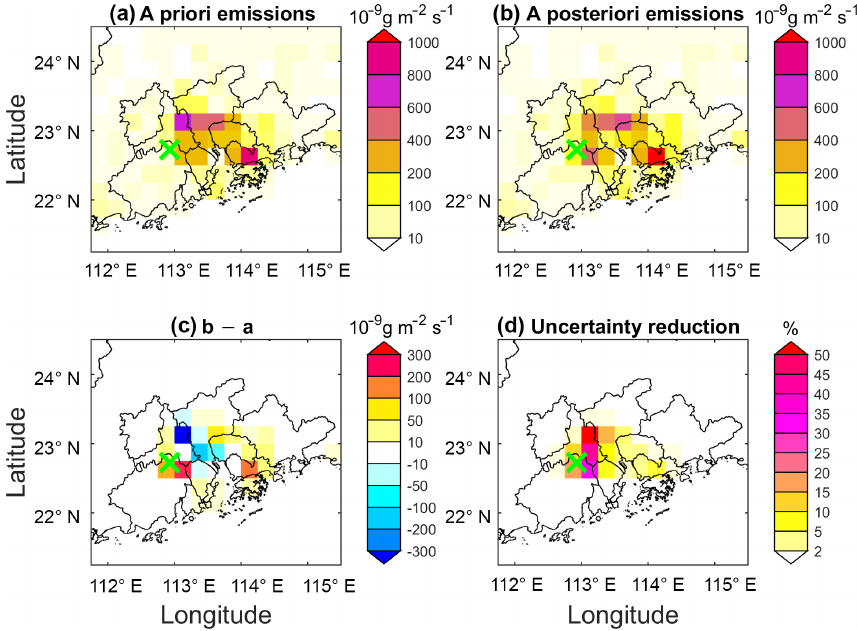
Figure 5. Maps of (a) a priori toluene emissions, (b) a posteriori toluene emissions, (c) differences between (b) and (a) , and (d) uncertainty reduction. The Heshan observation site is marked with a green